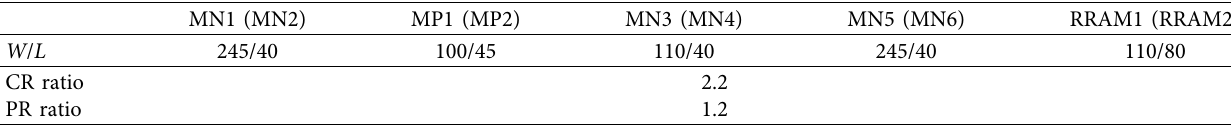
Figure 7: Micrograph of test chip and memory cell Table 2: Device size of nvSRAM memory cell.